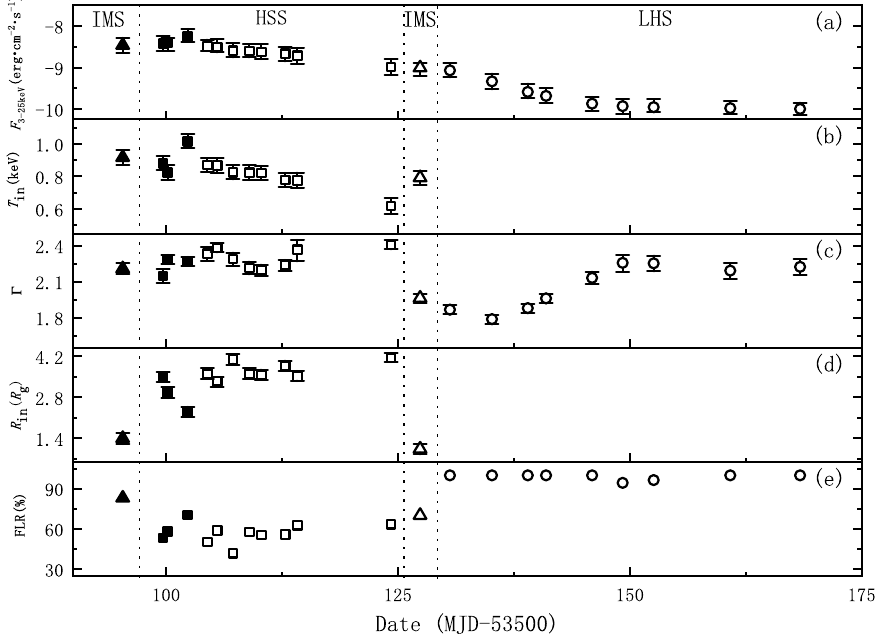
Figure 5. The evolution of spectral fitted parameters of H 1743-322 during the “faint” 2005 outburst. ( a ) the 3–25 KeV X-ray flux F 3–25 keV; ( b ) the inner disk temperature T in ; ( c ) the spectral index Γ , ( d ) the inner radius of accretion disk R in ; ( e ) the ratio of the fitted power-law component to the total flux FLR. The symbol types are the same as Figure